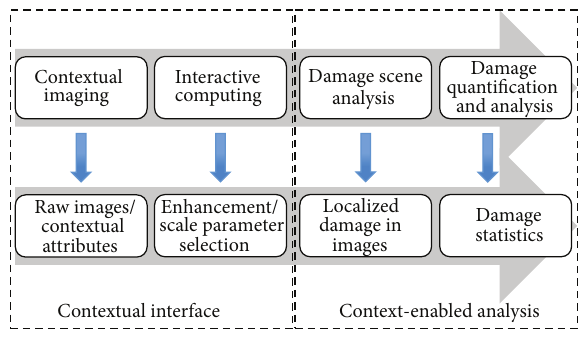
Figure 4: MIC framework for structural inspection: the operation flow (above) and the correspondingly generated dataflow